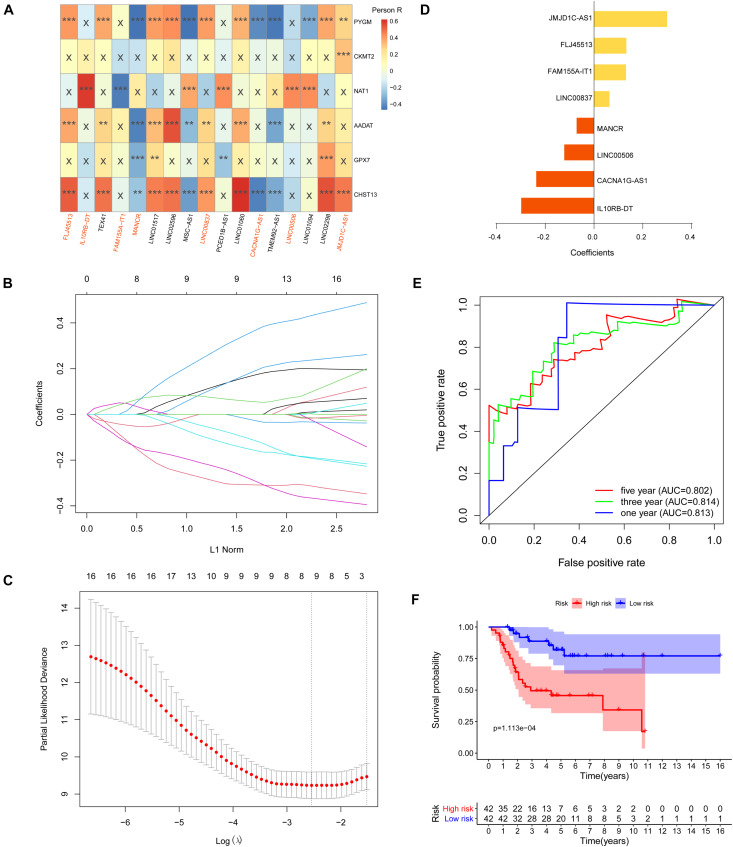
Construction of metabolism-related lncRNA signature. (A) Heat map of the correlations between metabolic genes and the 17 prognostic metabolism-related lncRNAs (**p < 0.01 and ***p < 0.001). (B,C) Lasso Cox regression analysis showed that eight of the 17 prognostic metabolism-related lncRNAs were good candidates for constructing the prognostic signature. (D) Coefficients of the eight metabolism-related lncRNA signature. (E) Eight metabolism-related lncRNA signature constructed using iterative Lasso Cox regression analysis. (F) ROC curve to evaluate 1, 3, and 5-year prediction efficiency of the eight metabolism-related lncRNA signature.